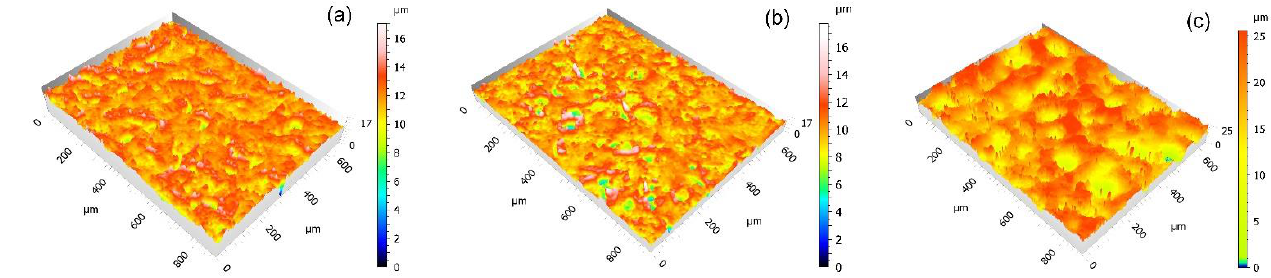
Figure 8. 3D captures (x20 confocal lens, Leica DCM8 high-definition microscope) of the coatings after projection during 4 s with glass microspheres at 0.4 MPa: ( a ) PFA, ( b ) FEP and ( c ) PTFE.